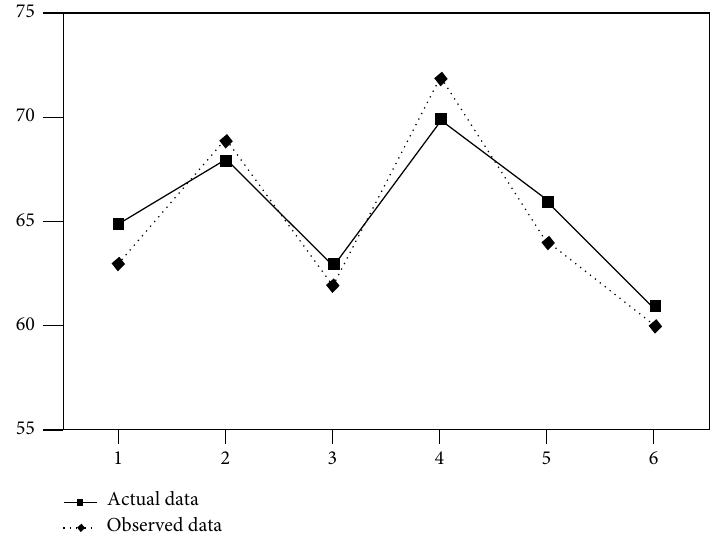
Figure 4: Data collected for room humidity.